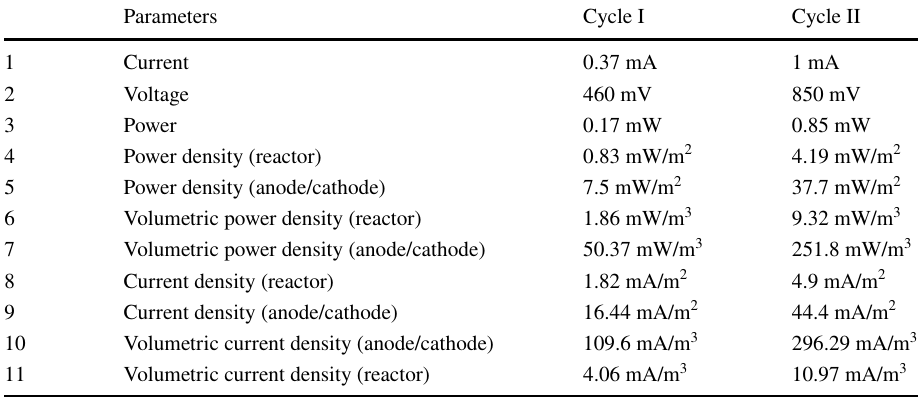
Table 3 Performance of EBCR during cycles